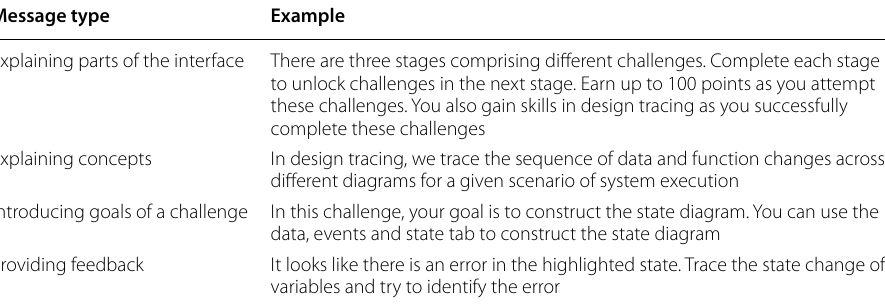
Table 1 Pedagogical agent message types in Module 1 of the TELE Message